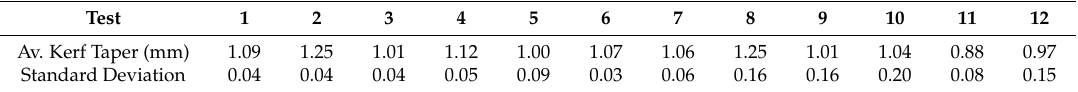
Table A2. Average kerf taper data. UNS A97075 (CFRP/UNS A97075 conf.).